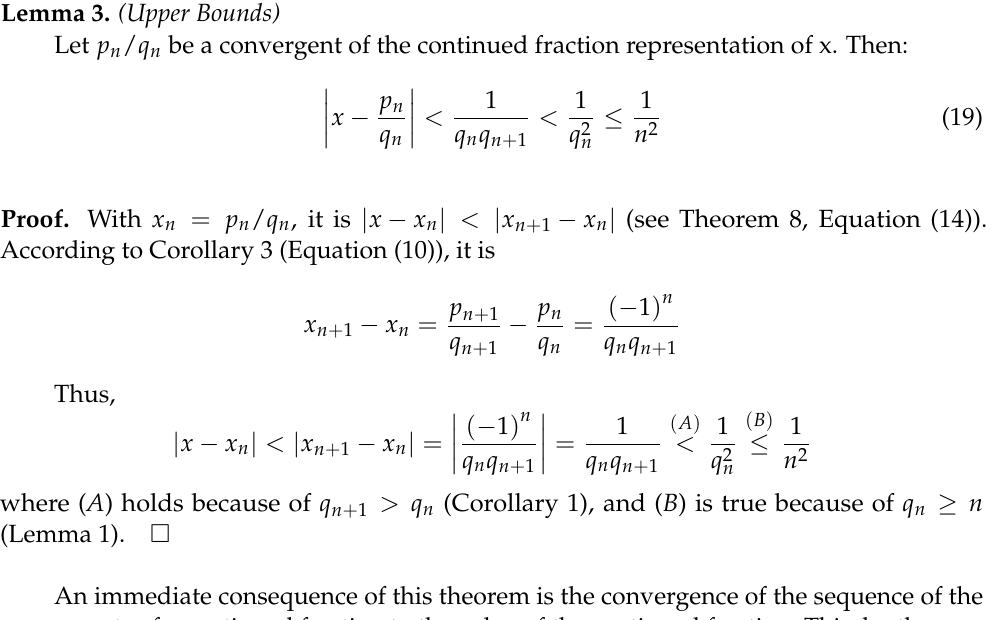
Figure 7. Computing the continued fraction of √2 .